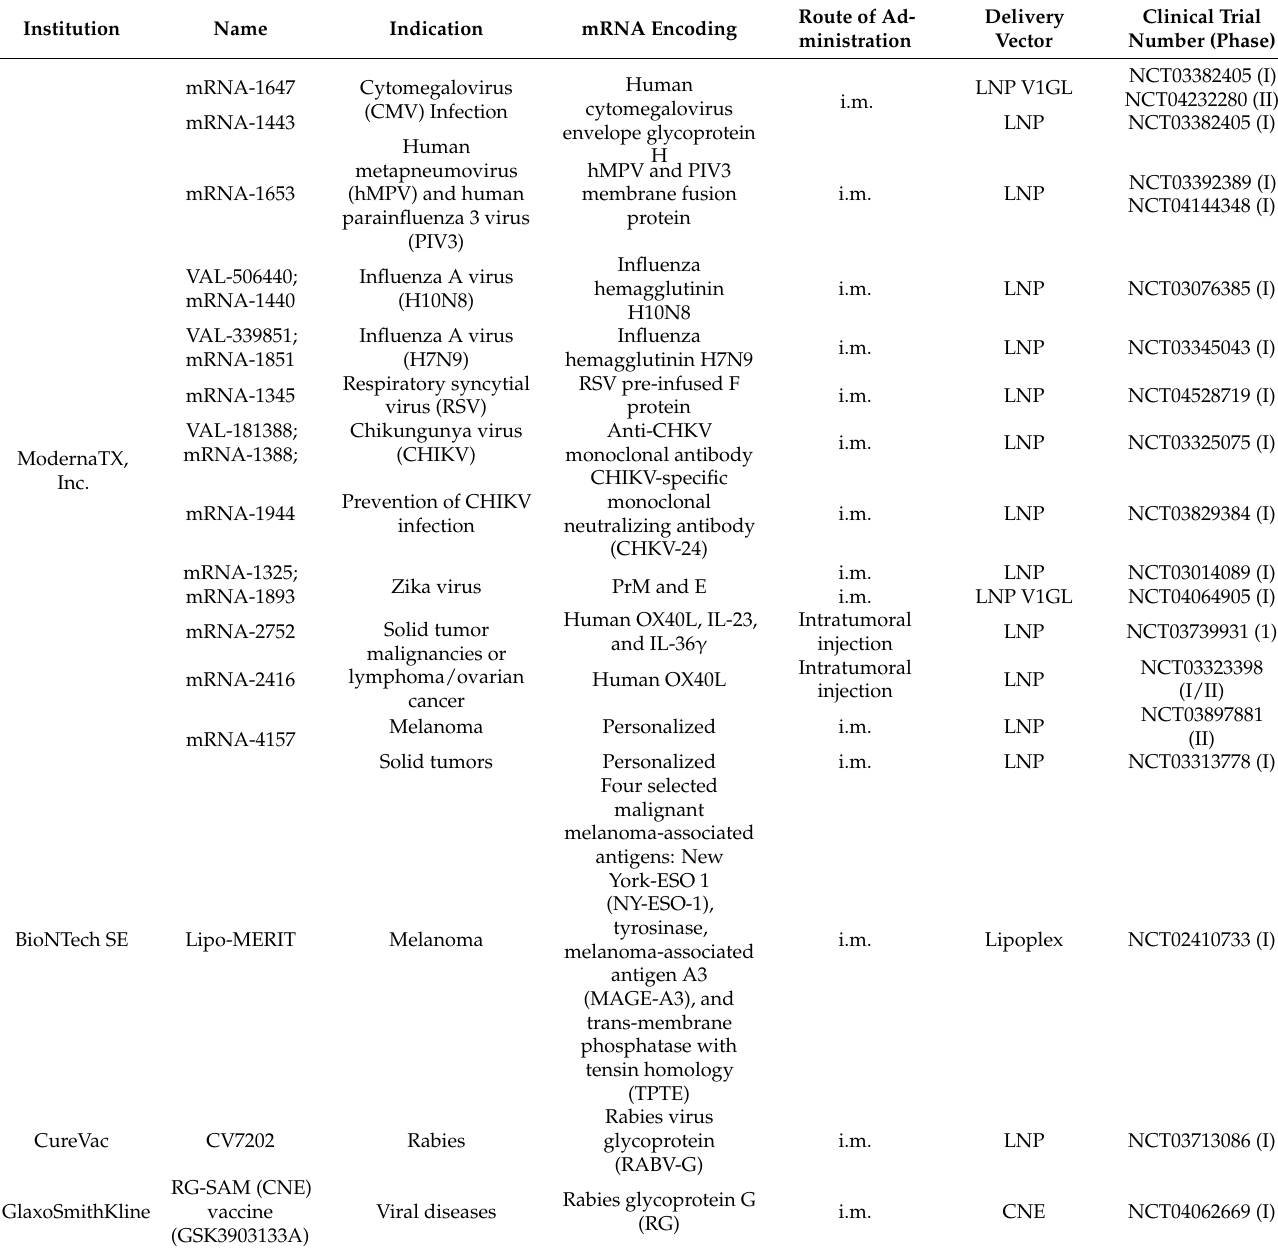
Table 5. Current clinical trials of